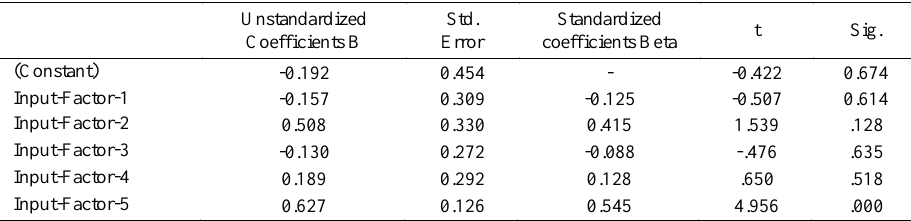
Table 2: Estimation of regression